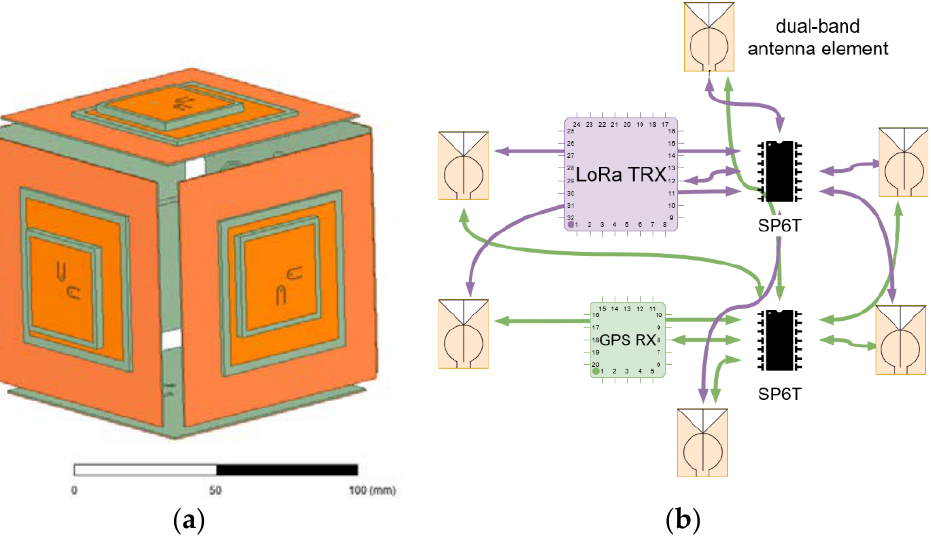
Figure 2. Switched-beams antenna concept: ( a ) antenna subsystem; ( b ) schematic of the switching mechanism. The hexahedron is not closed to allow the hazardous gas flowing into the sensor node.